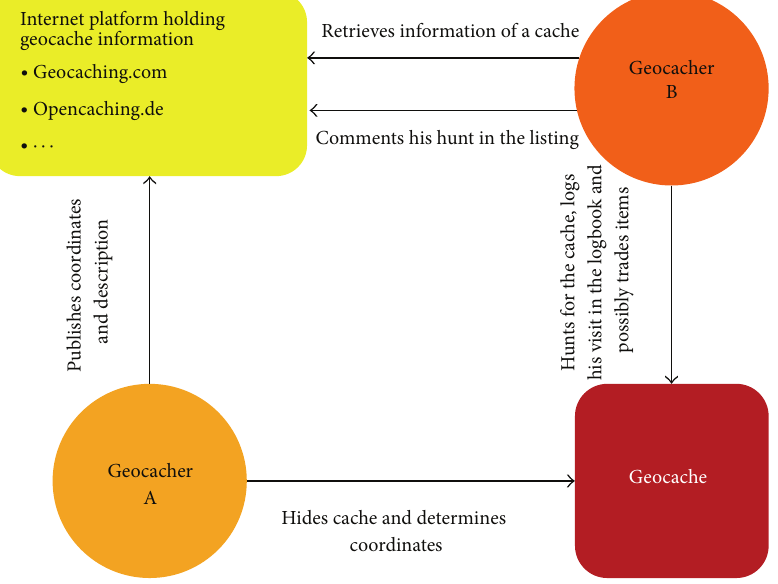
Figure 2: The geocache interaction